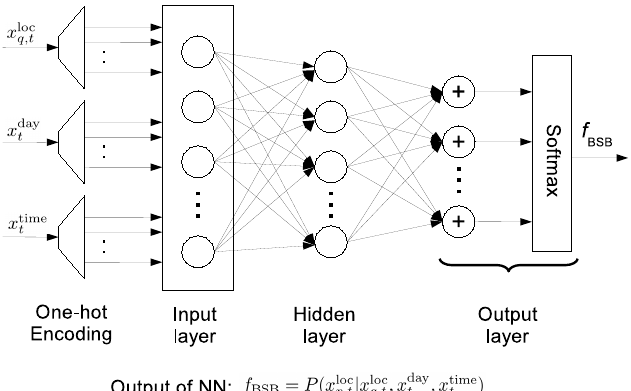
Figure 3. Architecture of the neural network for measuring behavioral similarity between persons p and q in the BSB